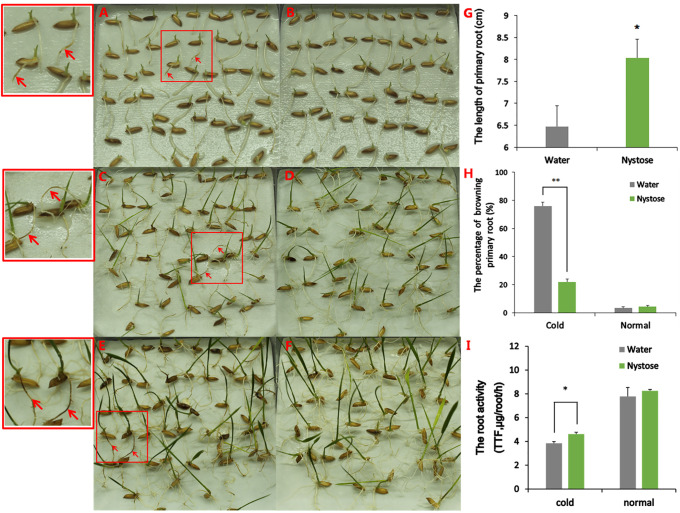
Phenotypes and physiological indices of rice roots under normal growth and cold stress.(A, C, E) Phenotypes of primary rice roots from seeds soaked in water, grown at 4°C for 2 d, and allowed to recover at 25°C for 1 d (A), 3 d (C), and 5 d (E). Red arrows in the boxes point to the brown discoloration of primary rice roots in the control group. Selected areas indicated by small red boxes are shown at higher magnification large red boxes. (B, D, F). Phenotypes of primary rice roots from seeds soaked in 75 mg/L nystose, grown at 4°C for 2 d, and allowed to recover at 25°C for 1 d (B), 3 d (D) and 5 d (F). (G) Length of primary rice roots after growing at 15°C for 10 days after sowing. Twenty independent experimental replicates were analyzed for each treatment, and data are presented as the mean ± SE. An independent t-test was performed to determine the differences between the SSN and SSW groups (*P<0.05). (H) The fraction of browning primary roots. Each experiment was performed in triplicate, and data are presented as the mean ± SE. An independent t-test was performed to determine the differences between groups (**P<0.01). (I) Metabolic activity of the roots. Each experiment was performed in triplicate, and data are indicated as the mean ± SE. An independent t-test was performed to determine the difference between groups (*P<0.05).